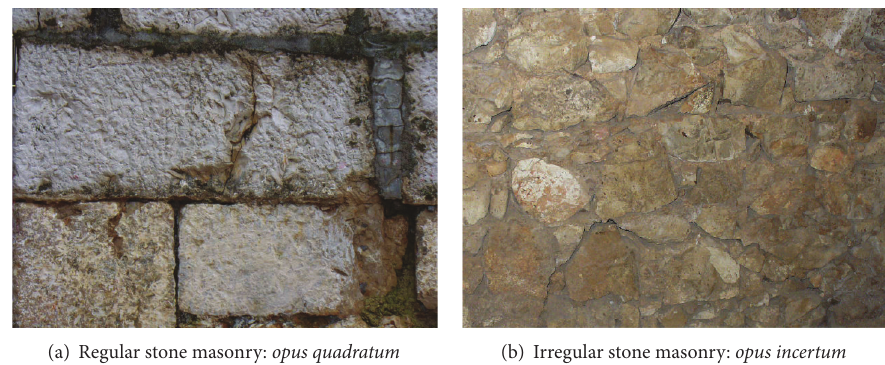
Figure 3: Madre Santa Maria del Borgo church, San Nicandro, Italy: church walls.